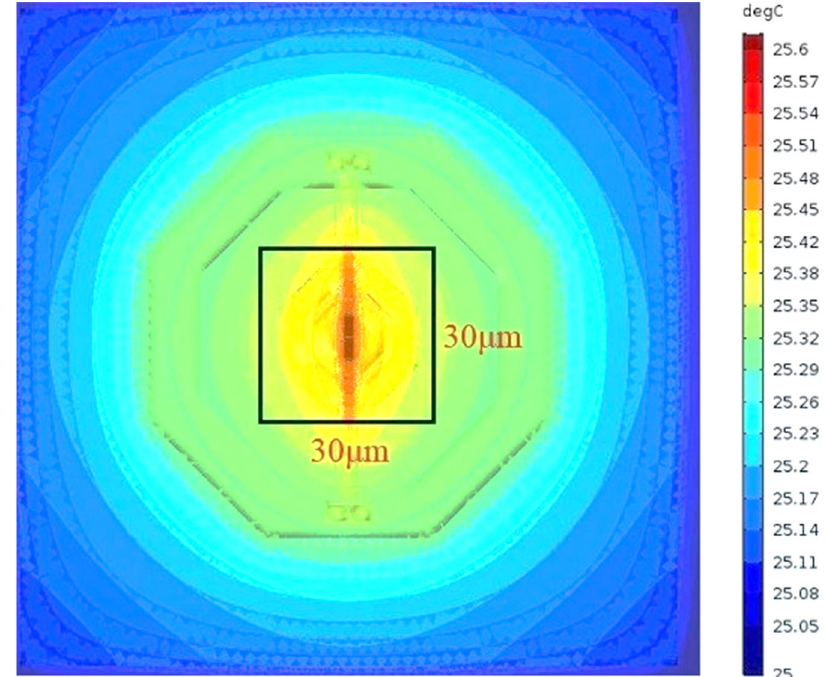
Figure 4. Temperature distribution of the proposed detector.